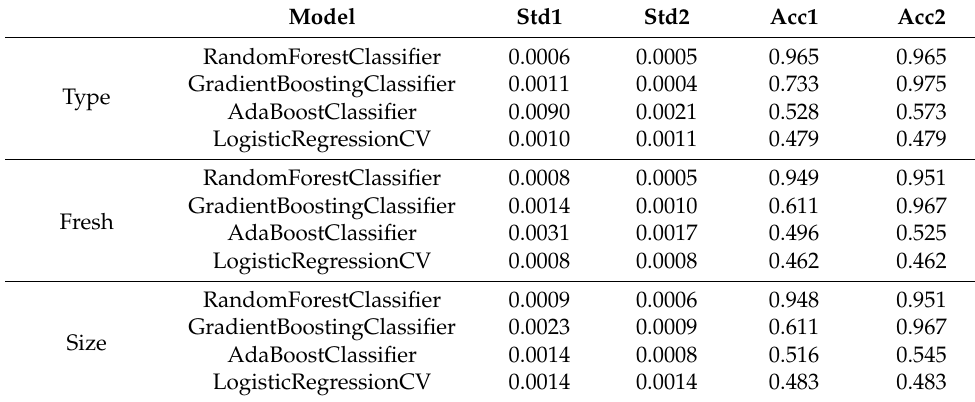
Table 3. Model evaluation of three classified landslide datasets, standard deviation, preliminary test accuracy, optimized test accuracy, and AUC